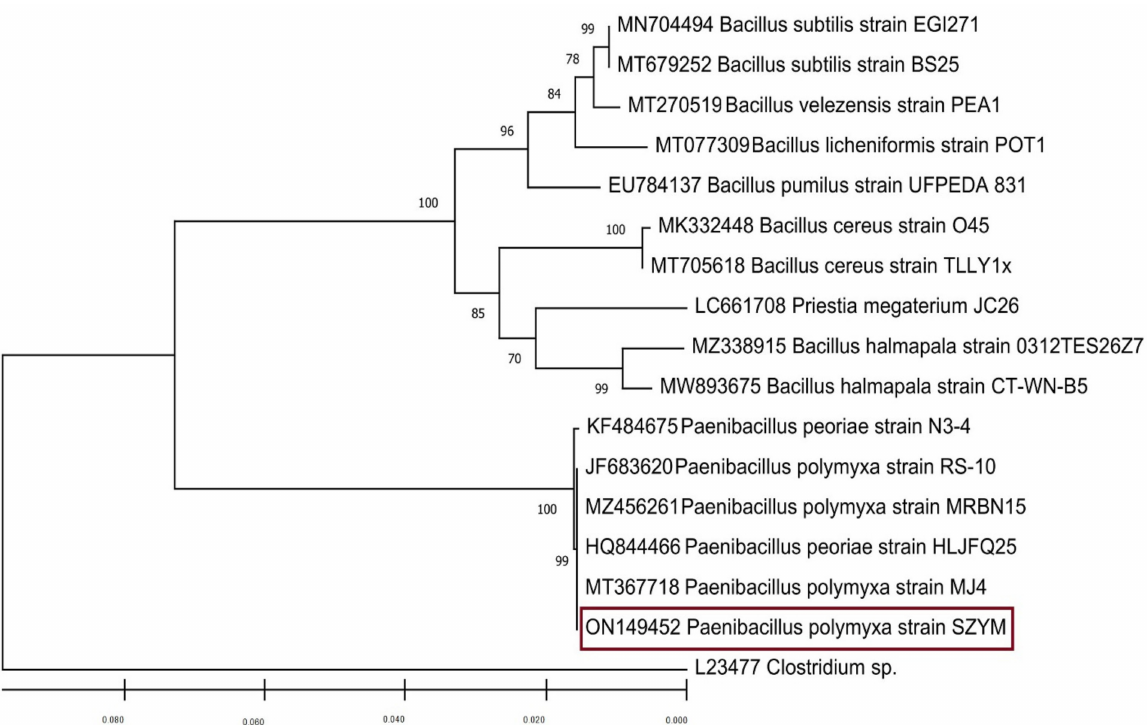
Figure 2. Phylogenic relationship of the locally isolated Paenibacillus polymyxa strain SZYM to the other Bacillus sp., as represented in the Bootstrap neighbor-joining